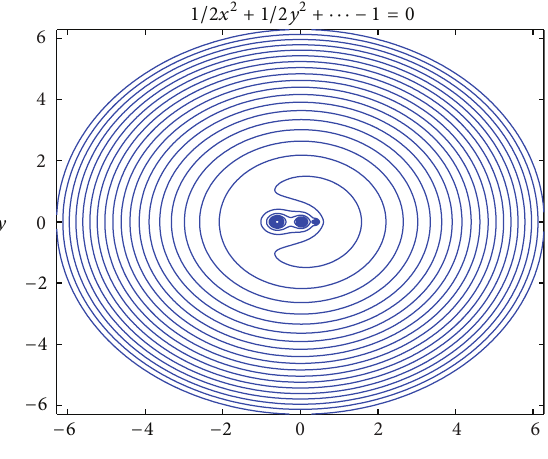
Figure 14: Curve of zero velocity ( 𝛼 CenAB-3) 𝑞 1 = 0.9971 , 𝑞 2 = = 0.1 , 𝐴 = 0.2 . 0.985 , and 𝐴 1 2